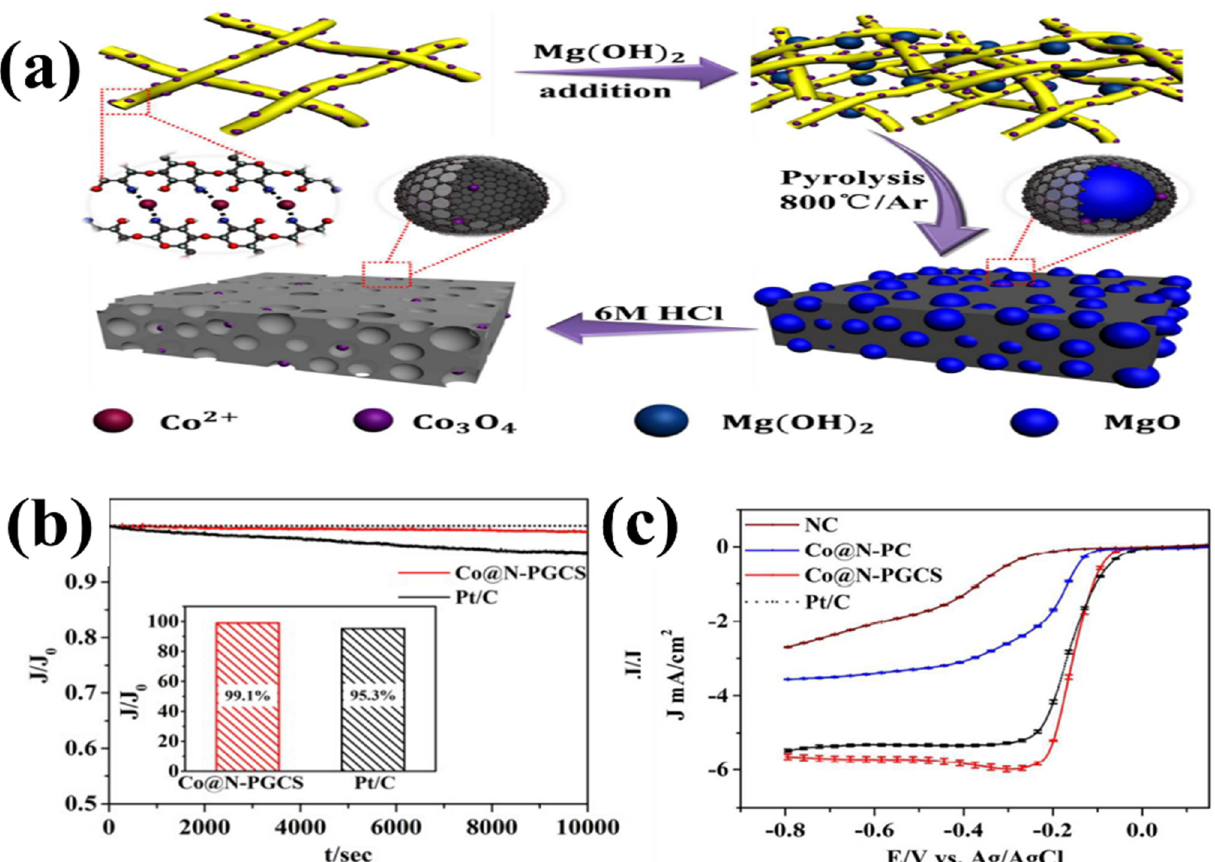
Figure 14. ( a ) Schematic illustration for the synthesis Co@N–PGCS, ( b ) stability curve, ( c ) linear sweep voltammetry (LSV) polarization curves of the catalysts tested in O 2 –saturated 0.1 mol L –1 KOH, adapted from [90].